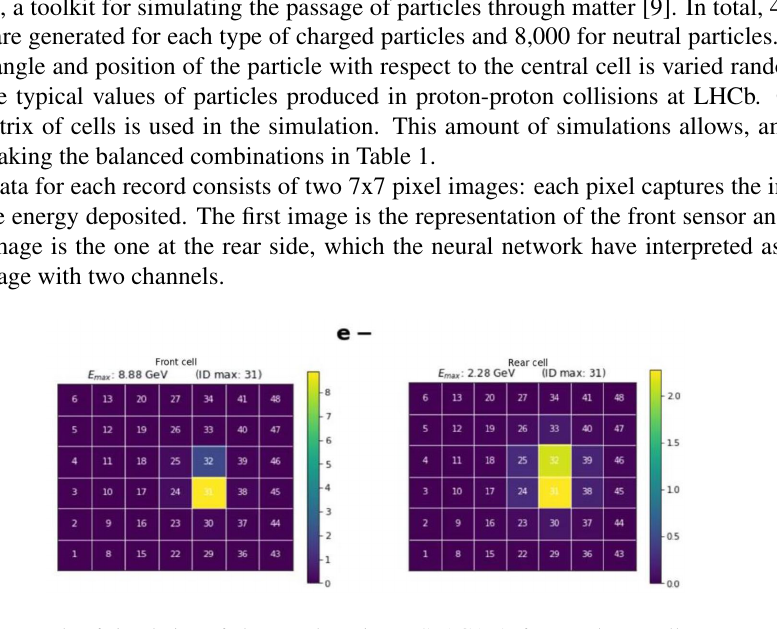
Figure 2. Example of simulation of electron detection at SPACAL’s front and rear